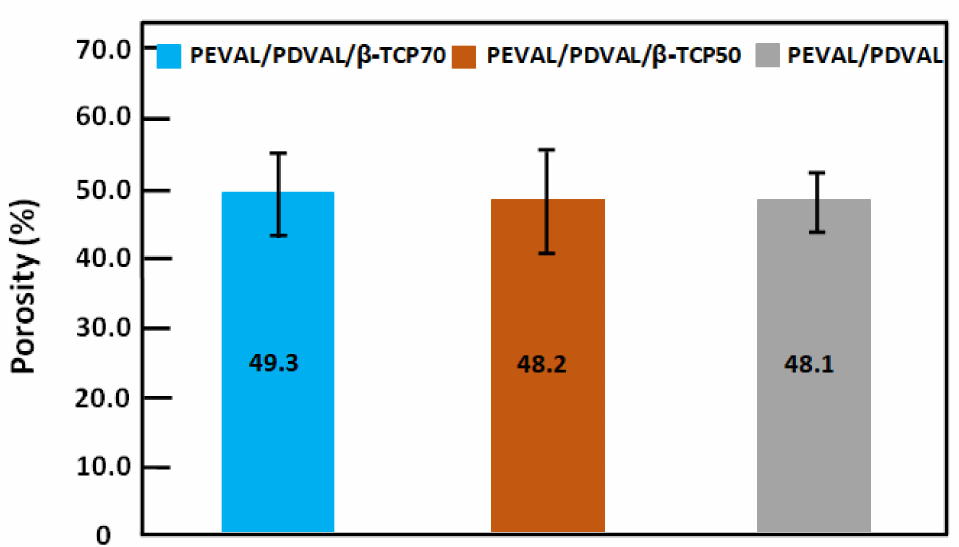
Figure 6. Results of micro-CT analysis. Porosity of the PEVAL/PDVAL blend, and the PEVAL/PDVAL/ β -TCP50 and PEVAL/PDVAL/ β -TCP70 hybrid materials, as determined by micro-CT. Error bars represent standard deviations, n =